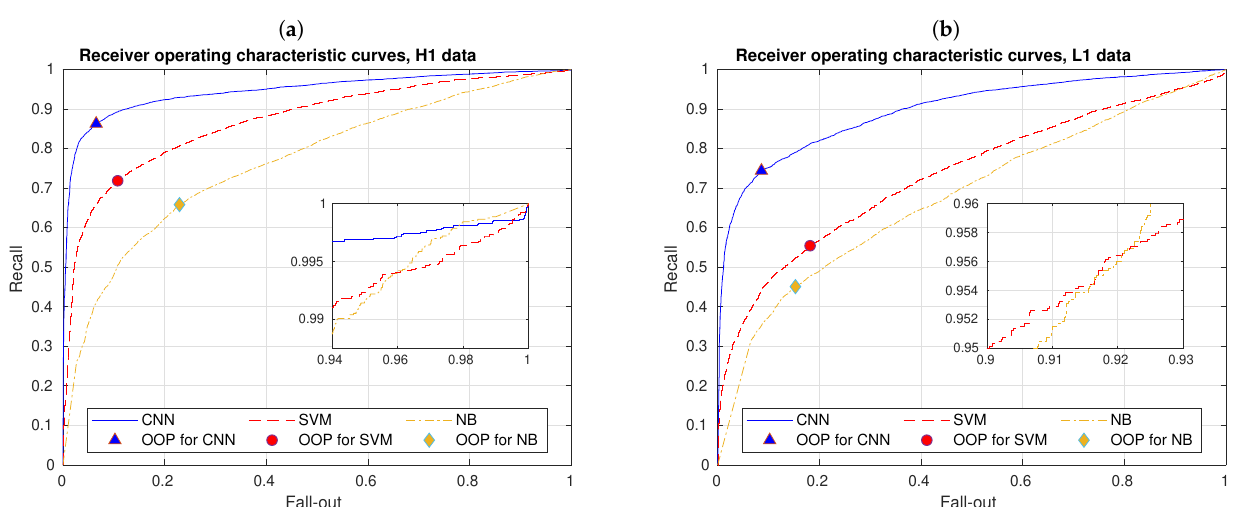
Figure 11. ROC curves for the CNNs, a SVM classifier with a linear kernel, and a Gaussian NB classifier. Data from H1 detector ( a ) and L1 detector ( b ) were used. For each ROC curve, its optimal operating point (OOP) is also shown. We set T win = 0.75 s and same CNN hyperparameter adjustments used in previous studies. The general trend, for almost all thresholds, is that our CNN has the best performance, followed by the SVM classifier, and finally by the NB classifier. Zoomed plots show small changes in performances near point ( 1,1 ) , even though these do not affect the general